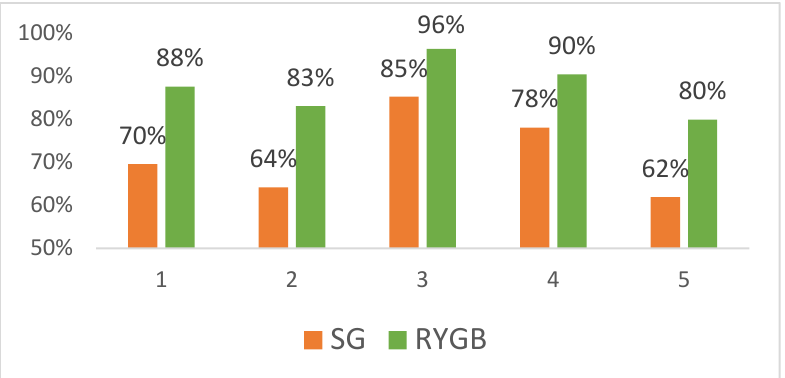
Figure 3. Success rates attending different criteria at 5-year follow-up for LSG and RYGB. (1) EWL > 50%; (2) BMI < 35; (3) Biron criteria is defined by BMI < 35 if the initial BMI < 50 kg/m 2 and BMI